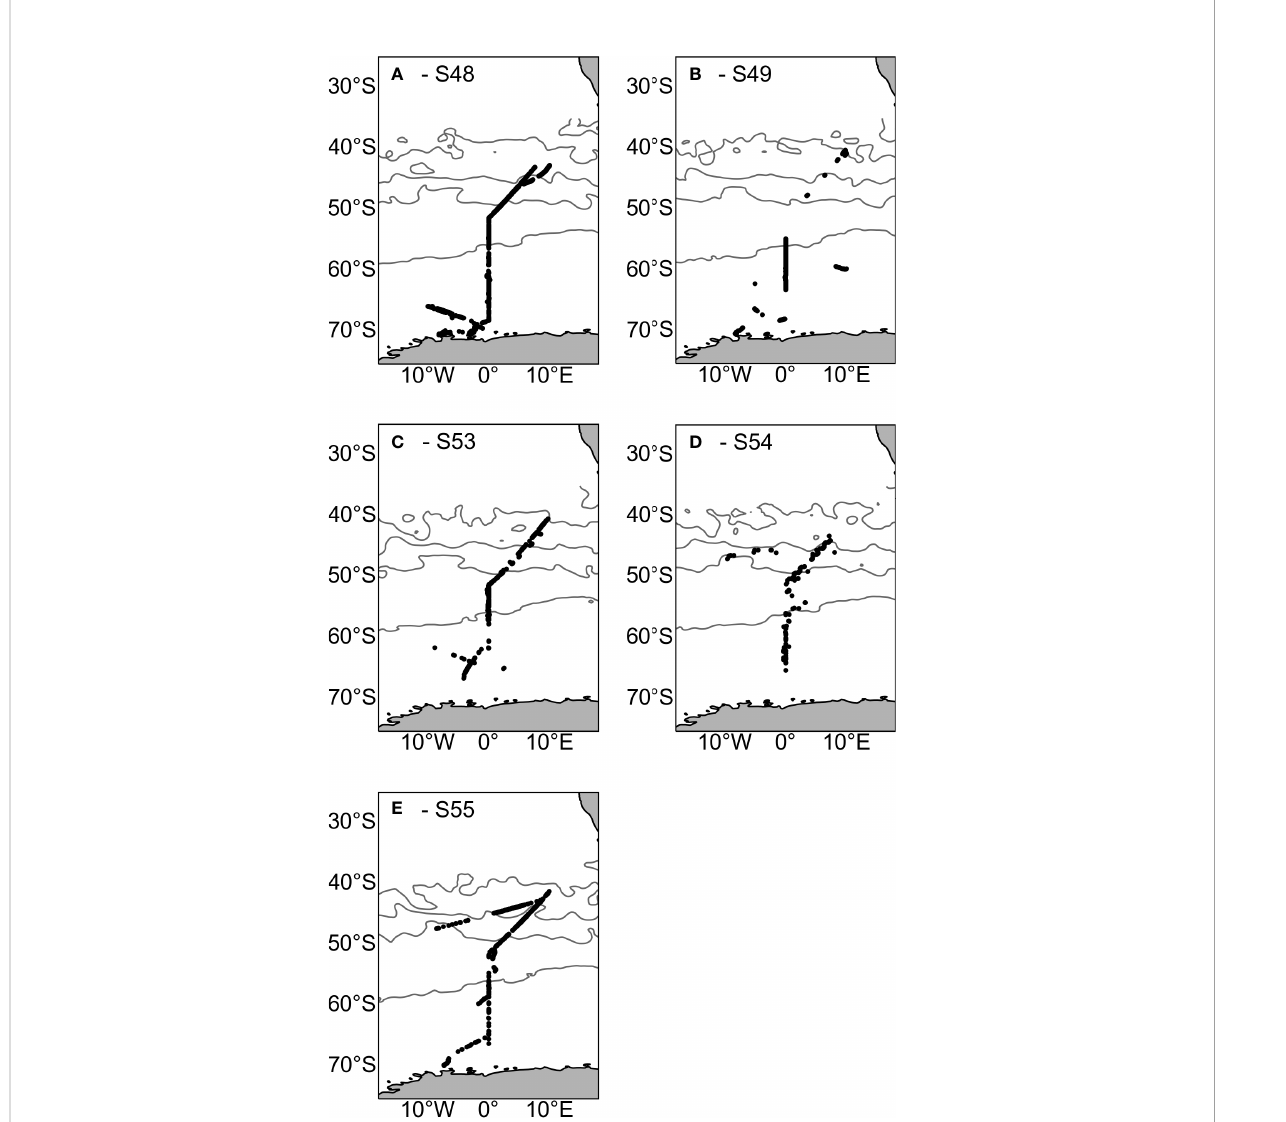
FIGURE 1 Individual plots of the night-time active chlorophyll-a fl uorescence measurement points which passed the quality control (QC) procedure for each cruise independently (A) SANAE 48 (S48), (B) SANAE 49 (S49), (C) SANAE 53 (S53), (D) SANAE 54 (S54) and (E) SANAE 55 (S55), along with the respective frontal positions indicated for each cruise from north to south - Sub-Tropical Front (STF), Sub-Antarctic Front (SAF), Antarctic Polar Front (PF) and Southern Boundary (SBdy), delineating the corresponding zones between the fronts (Sub-Antarctic Zone (SAZ), Polar Frontal Zone (PFZ), Antarctic Zone (AZ) and Southern Antarctic Circumpolar Current Zone